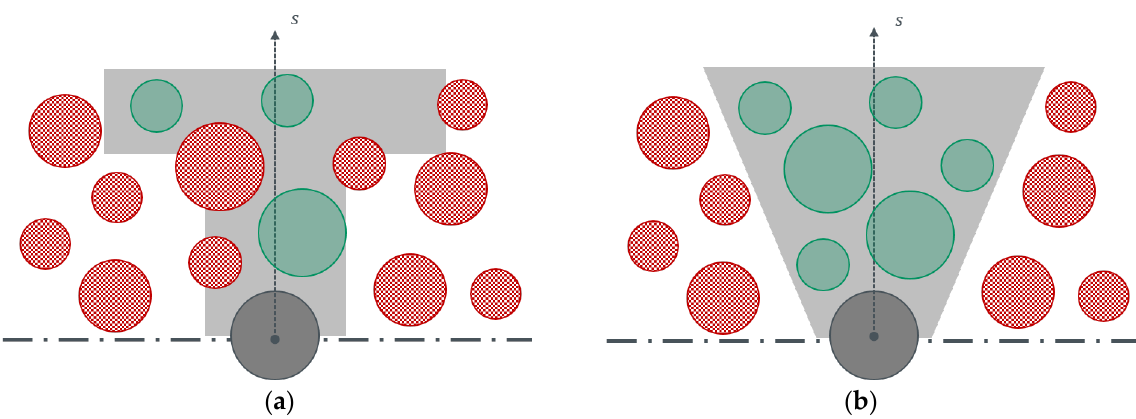
Figure 4. Schematic procedure of the proposed method; ( a ) The initial design space (grey) with deactivated elements (red) causing a manufacturing conflict. ( b ) Conflicted elements are activated (green) iteratively, so that the modified design space is free of deactivated elements causing manufacturing conflicts.